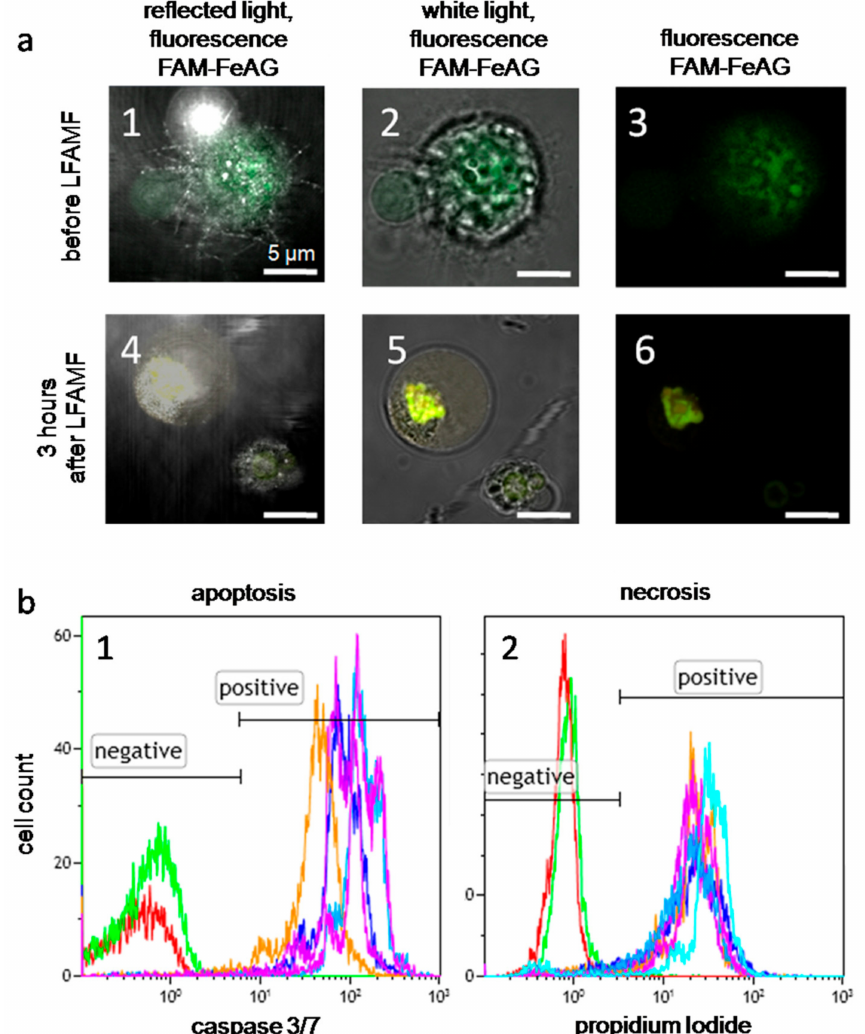
Figure 5. E ff ects of AS-FeAG and low frequency alternating magnetic field (LFAMF) in vitro. ( a ) Fluorescence microscopy of Ehrlich cells with FAM-labeled As-FeAG before and after LFAMF treatment for 10 min represented in reflected light with fluorescence ( a1 , 4 ), white light with fluorescence ( a2 , 5 ) and only fluorescence ( a3 , 6 ). Scale bar: 5 µ m. ( b1 ) Flow cytometry analysis of apoptosis 3 h after the treatment using the caspase 3 / 7 activity; ( b2 ) the level of necrosis determined by propidium iodide accumulation in dead cells. The red curve corresponds to intact cells without staining; the green curve represents the basic level of non-treated cells; purple—to cells treated with FrFeAG (6%);